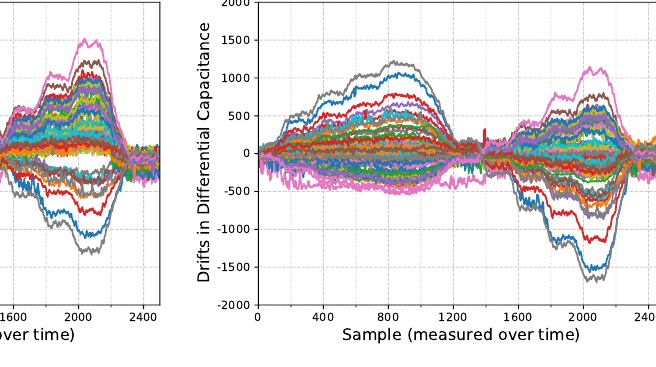
(d) Change in differential capacitance due to tem- perature changes compared to reference measure- ment (at 20 ◦ C) after Tx group shift.